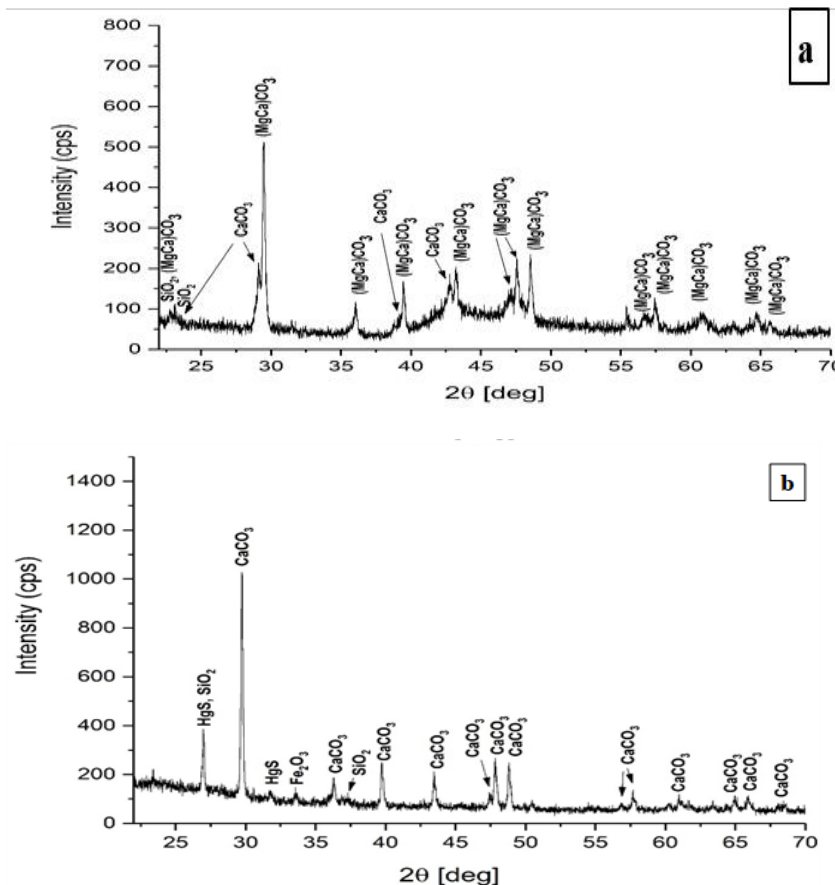
Figure 12. Qualitative phase analysis by X-ray diffraction of the fresco sample covered with a red painting layer, whose mortar shows good adhesion to the sandstone wall: ( a ) analysis of the mortar; ( b ) analysis of the pictorial layer.